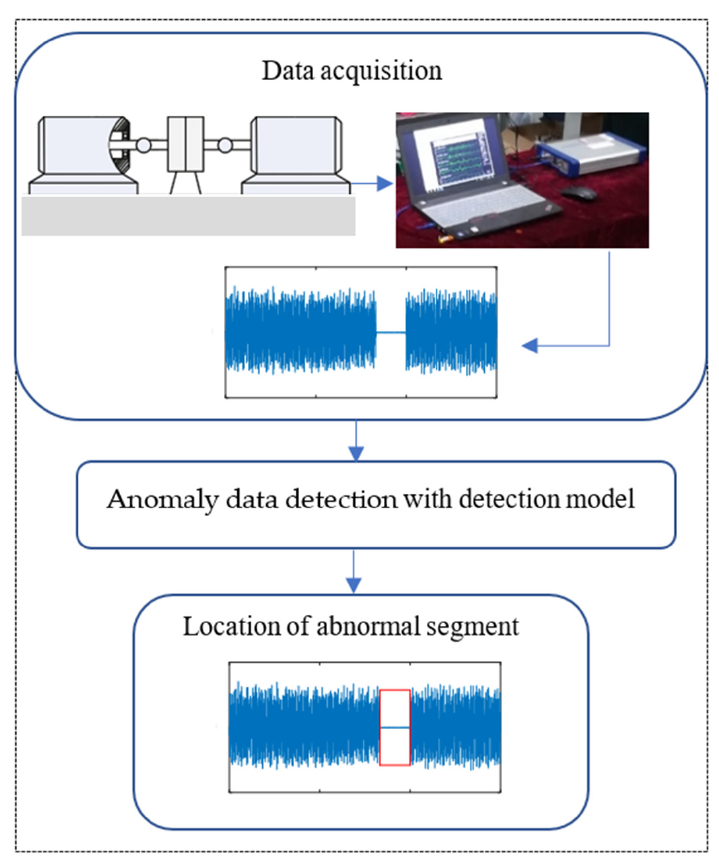
Figure 1. Flow of bearing vibration signal acquisition and anomaly data detection.